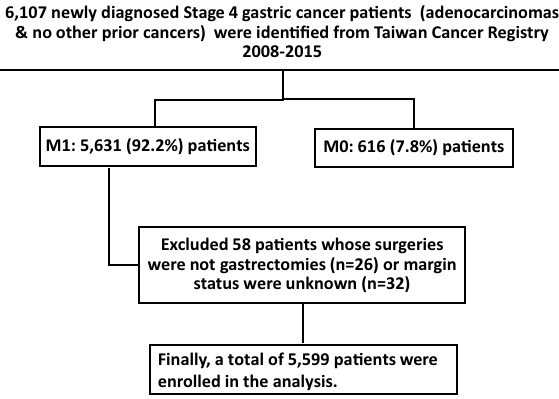
Figure 1. Diagram showing steps to select the study population.